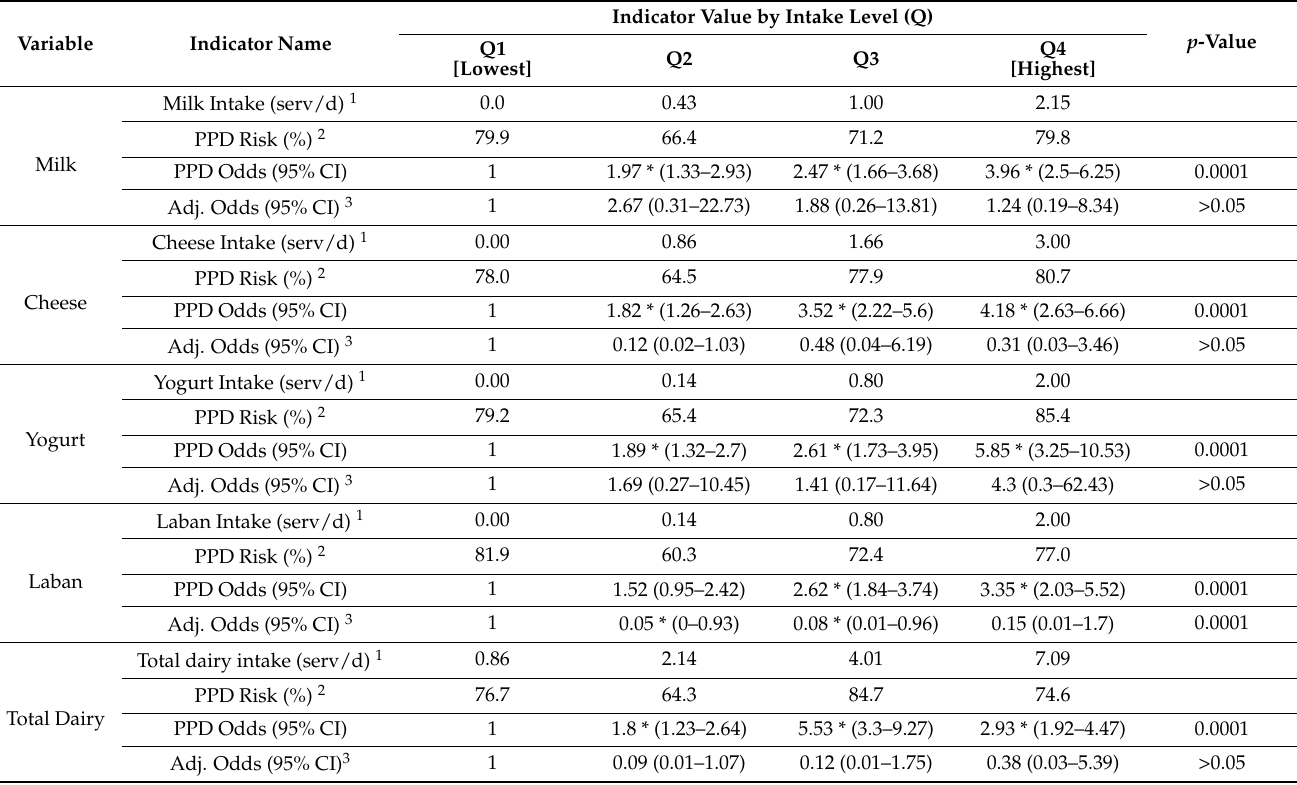
Table 2. The association between the daily consumption of dairy products and PPD.